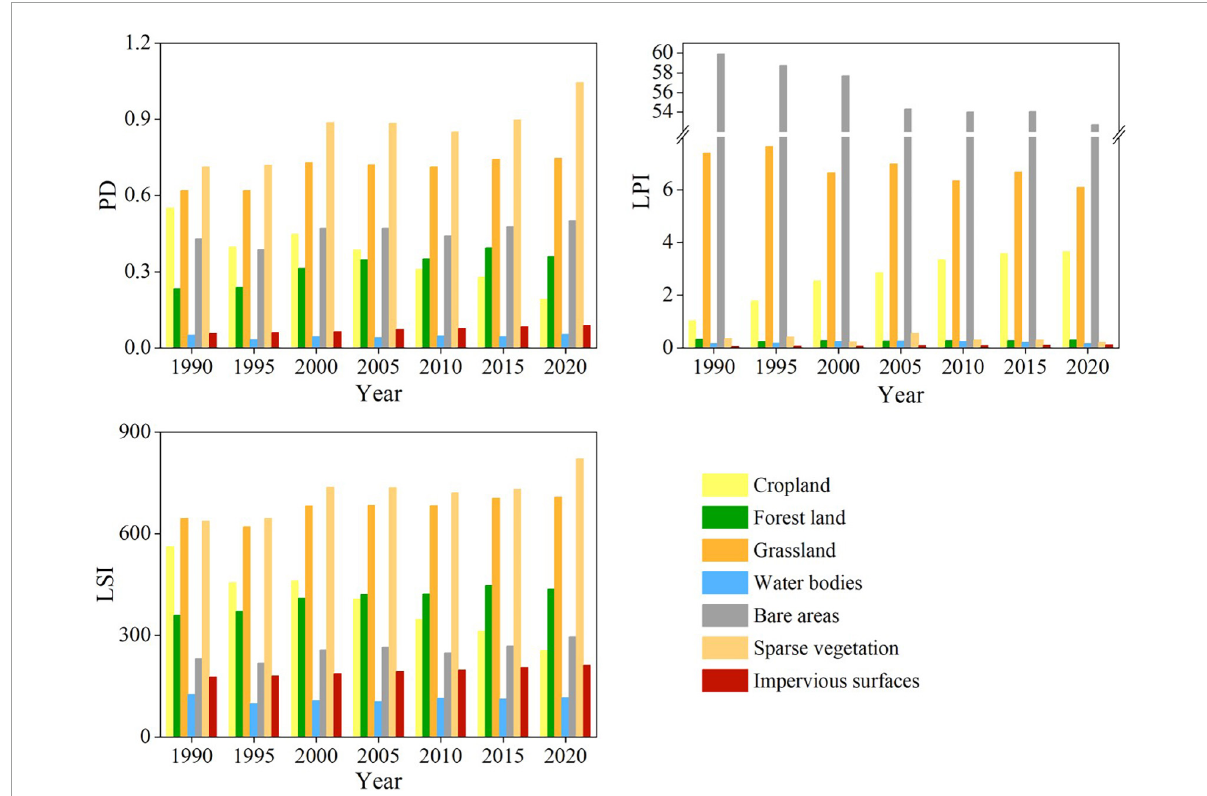
FIGURE3 The changes in landscape metrics at the category level from 1990 to